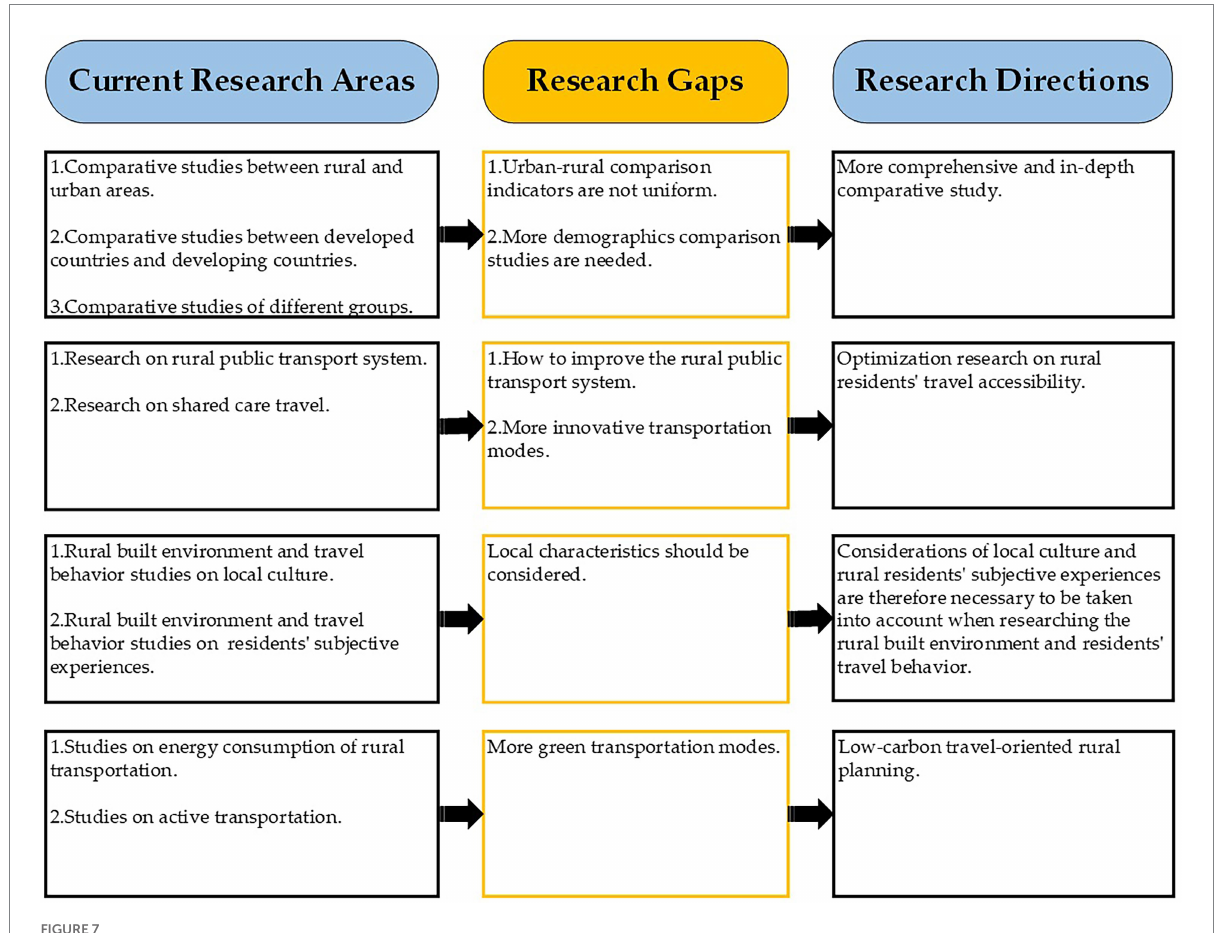
FIGURE 7 Framework linking current research topics to future research